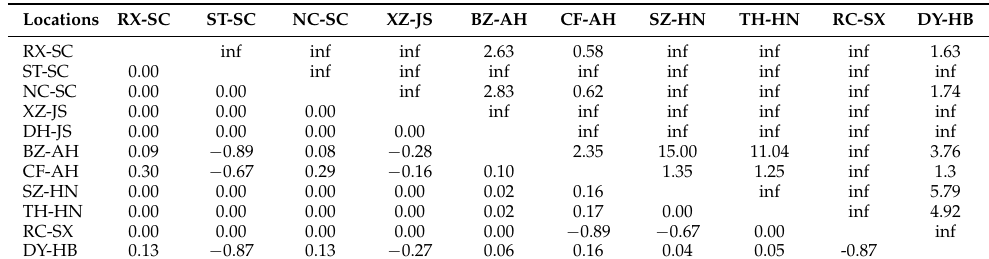
Table 5. Pairwise F ST (below diagonal) and gene flow N m (above diagonal) among 10 populations of P. tectus in winter wheat of China.